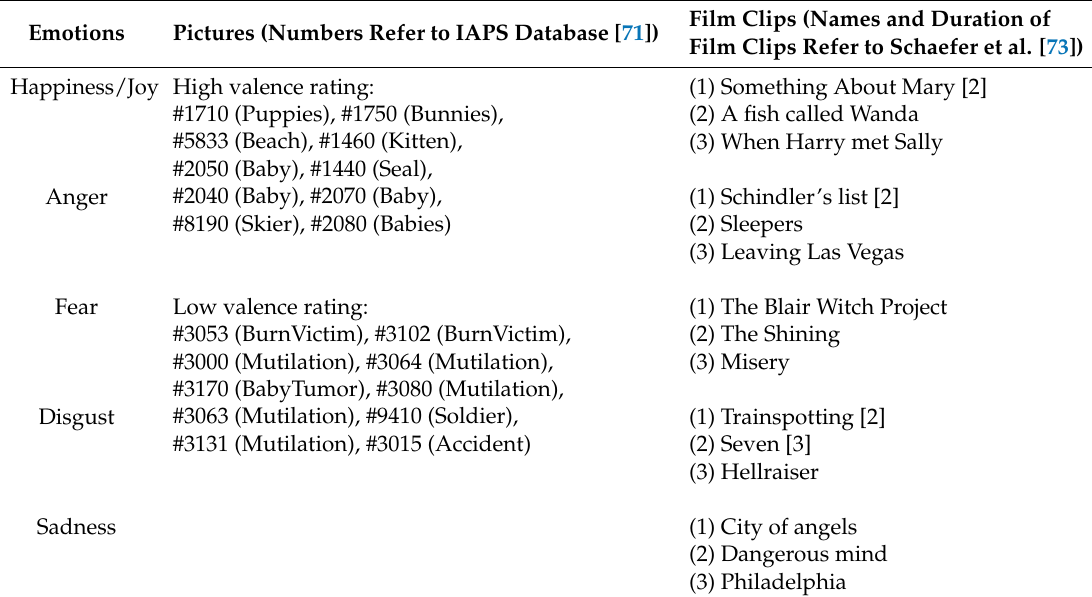
Table 2. Elicitation of basic emotions using referenced